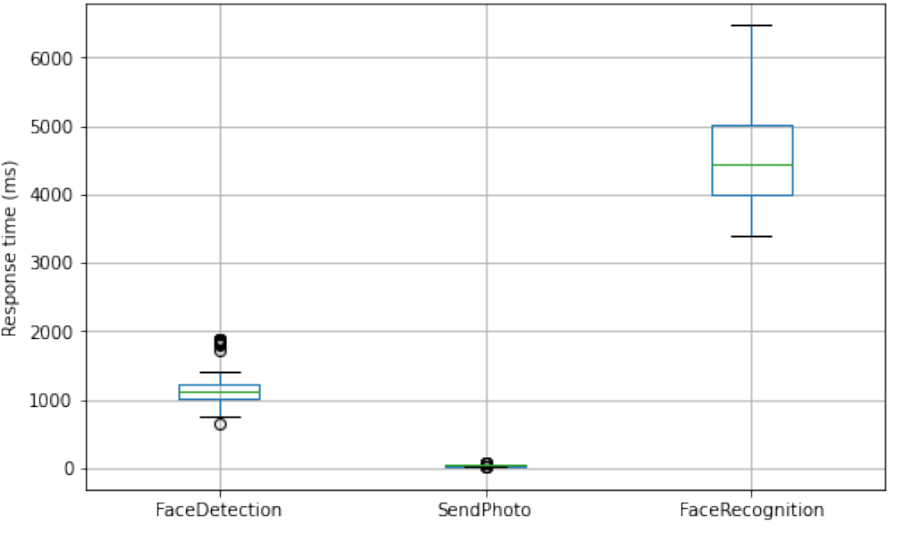
Figure 7. Performance parameters box-plot diagram.